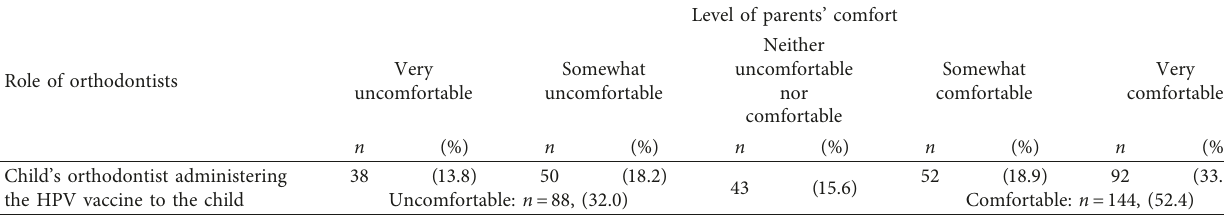
Table 2: Parent comfort level with orthodontists as HPV vaccinators ( N � 275).